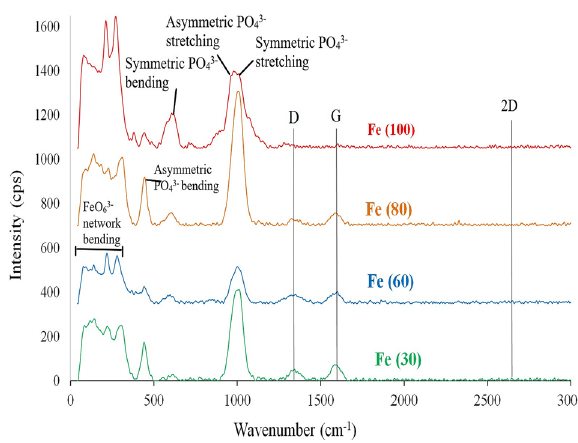
Figure 3. Raman spectra for microwave solid state synthesized sodium iron phosphate